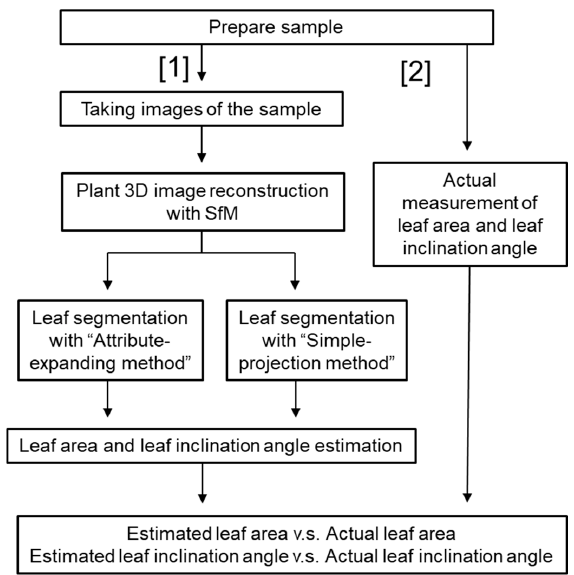
Figure 1. Flow chart of the process from 3D reconstruction, leaf segmentation to estimation of structural parameters.